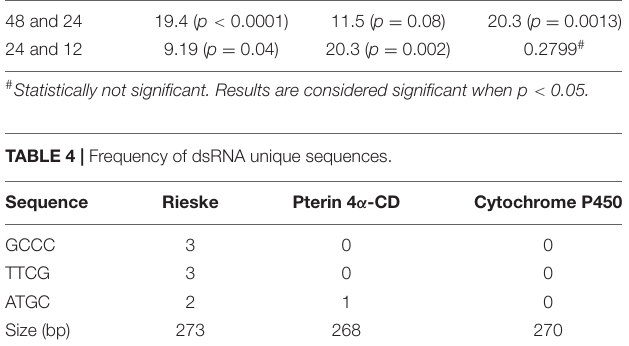
( Supplementary Table 1 ). Blast2Go generated gene